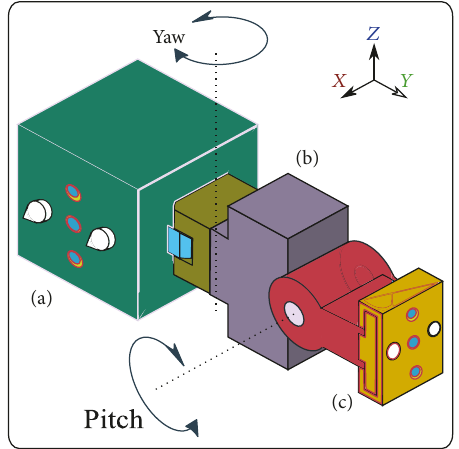
Figure 9: Model diagram of CONRO MSRR.